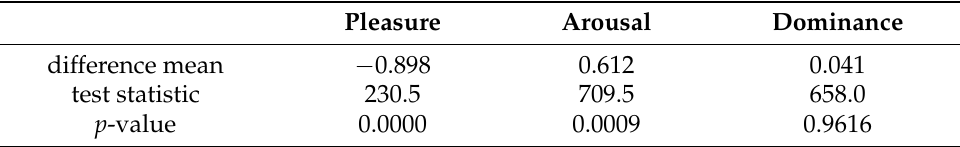
Table 6. Testing the differences of PAD labels between the paired positive and negative opinions—results of two-sided Wilcoxon test.